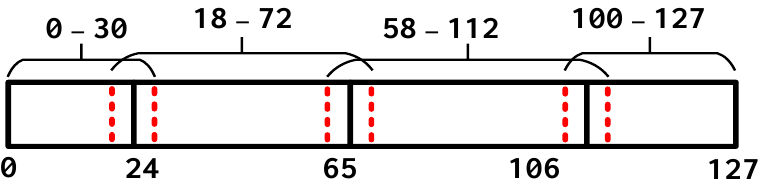
Figure 10. Segmentation of adjustable delay range.